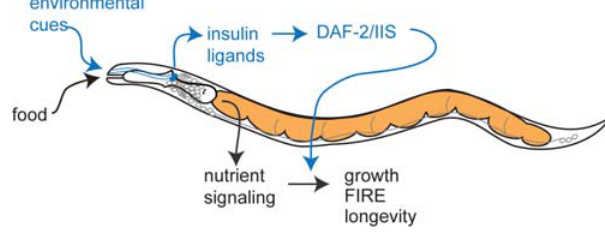
Figure 6. Model for the interactions between DR and DAF-2/IIS on growth, FIRE response and lifespan. Food intake and nutrient signaling have dramatic effects on growth, FIRE response and longevity in C. elegans . This paper reports that levels of DAF-2/IIS can modify these three nutrient-dependent processes. We propose that levels of DAF-2/IIS may be under control of environmental cues that modulate insulin ligand production.